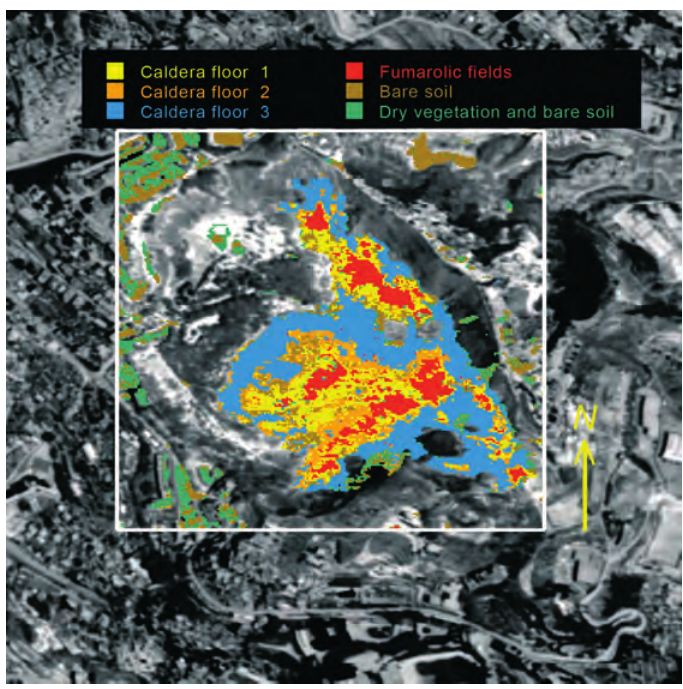
Fig. 8. Map of the main geo-mineralogical units outcropping at the Solfatara